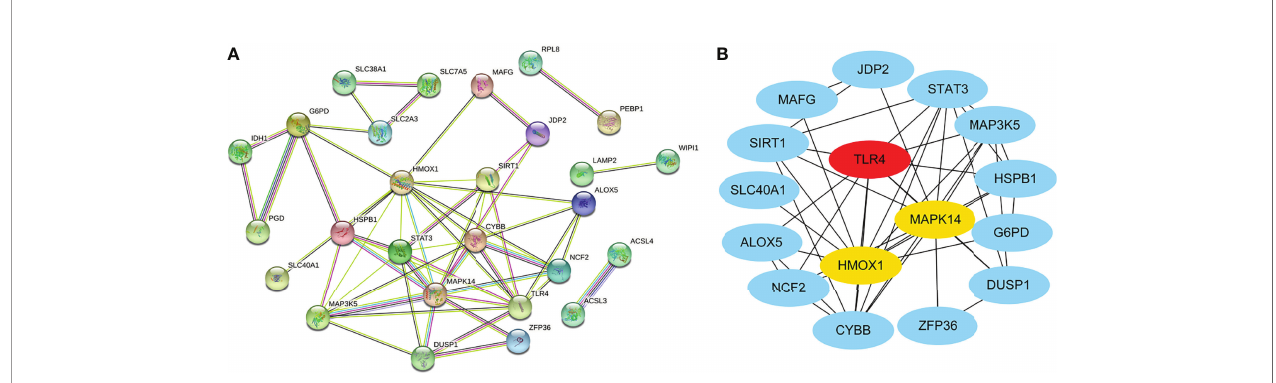
FIGURE 3 | Protein – protein interaction (PPI) network of ferroptosis DEGs. (A) PPI network of differentially expressed ferroptosis DEGs. (B) Subnetwork of hub genes from the PPI network. Node color re fl ects the degree of connectivity (red color represents a higher degree, and blue color represents a lower degree).